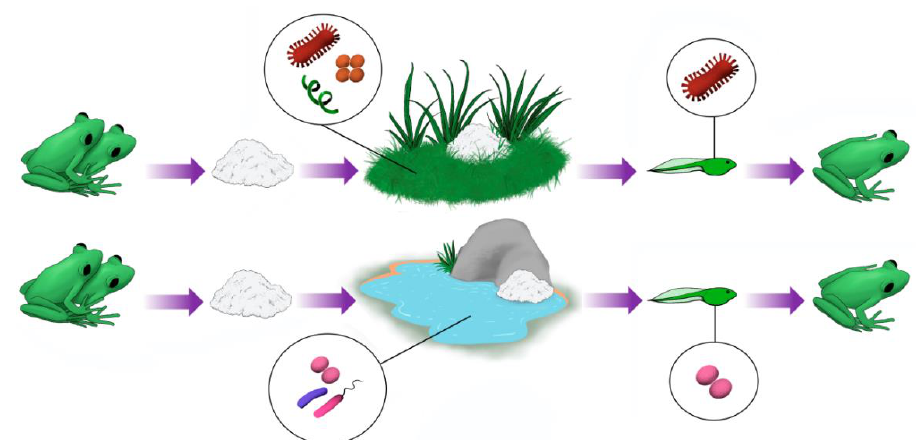
Figure 8. Anuran foam nest microbiomes originate from the microbiome of the environment where these nests are deposited. However, certain groups of microorganisms are clearly enriched in nests compared to their natural environments. This suggests that these microorganisms may be beneficial to tadpoles in the early stages of development.